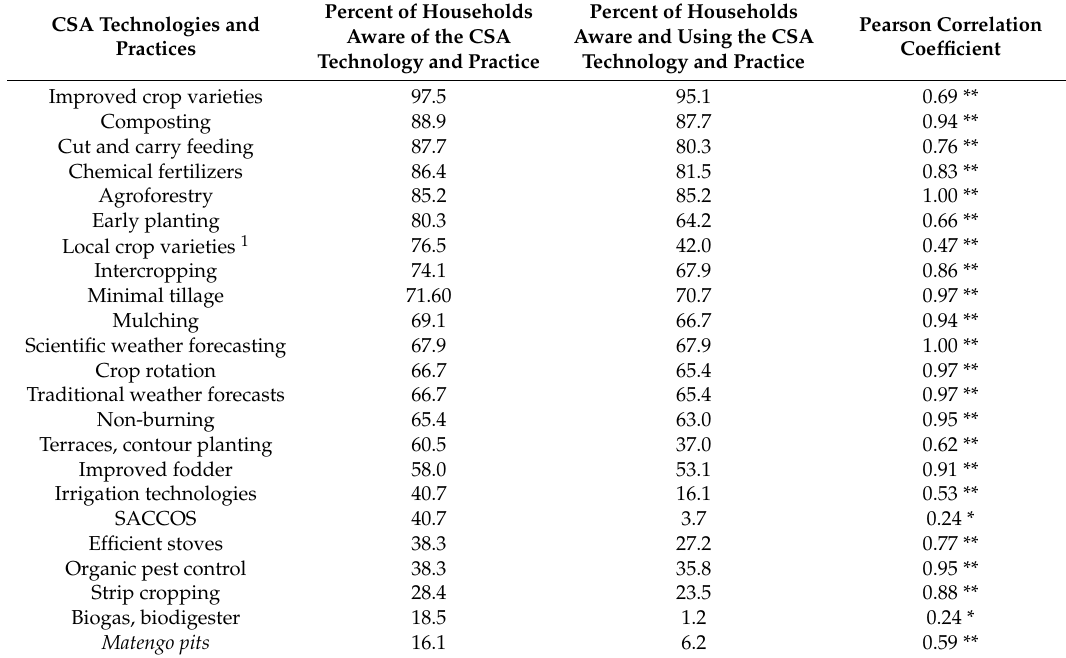
Table 4. Awareness and use of CSA technologies and practices in